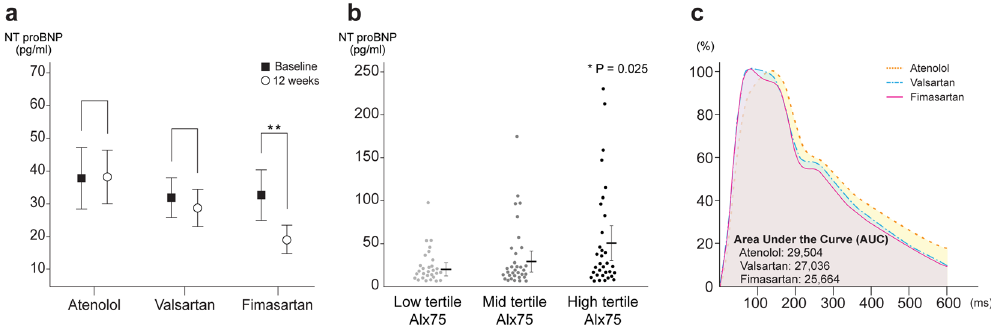
Figure 4. Plasma NT-proBNP level and the contour change of arterial wave reflection. ( a ) Mean change in plasma NT-proBNP level between baseline and 12 weeks (Mean ± SD). Plasma NT-proBNP level was also significantly lowered in ARB groups after 12-week treatment, only fimasartan group showed significant reduction of plasma NT-proBNP level between baseline and 12 weeks (by paired t-test). ( b ) The difference in NT-proBNP level according to AIx75 tertile group. Plasma NT-proBNP levels increased with the increase in AIx75 tertile. ( c ) The contour of arterial wave reflection after 12-week treatment had the lowest trend in fimasartan group, although there were no significant differences in the AUCs of arterial wave reflection (p =